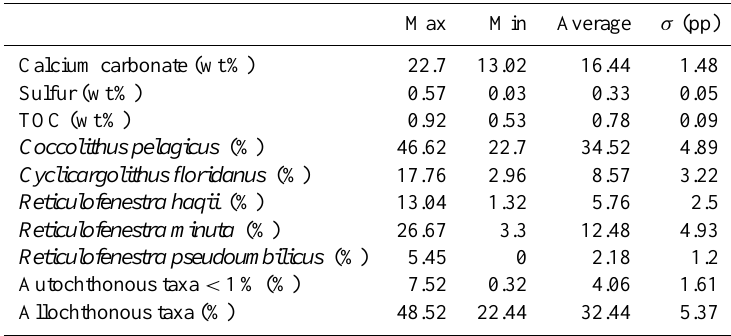
Figure 4. Sedimentological (% of grains > 63µm) and geochemical parameters (calcium carbonate, organic carbon, sulfur, and C/S ratio) of the high-resolution section (a) . Coccolith abundances are shown as coccoliths encountered per field view of the light microscope and the abundance of autochthonous and allochthonous specimens in percent (b) . Three basic depositional intervals (I–III) were defined based on a simple visual evaluation of the gathered data sets. Table 1. Overview of the nine studied proxies. Table shows highest and lowest values, average content (arithmetic mean), and the standard